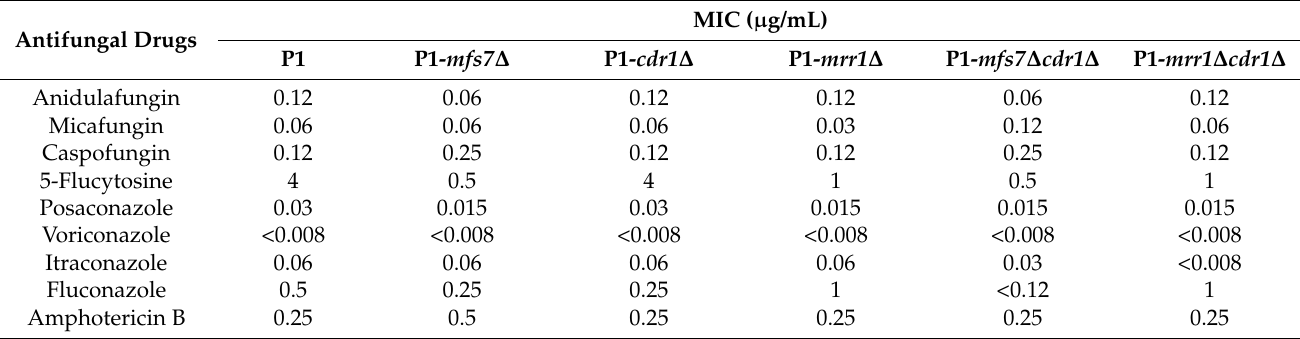
Table 3. Antifungal MICs of C. lusitaniae P1 and mutant